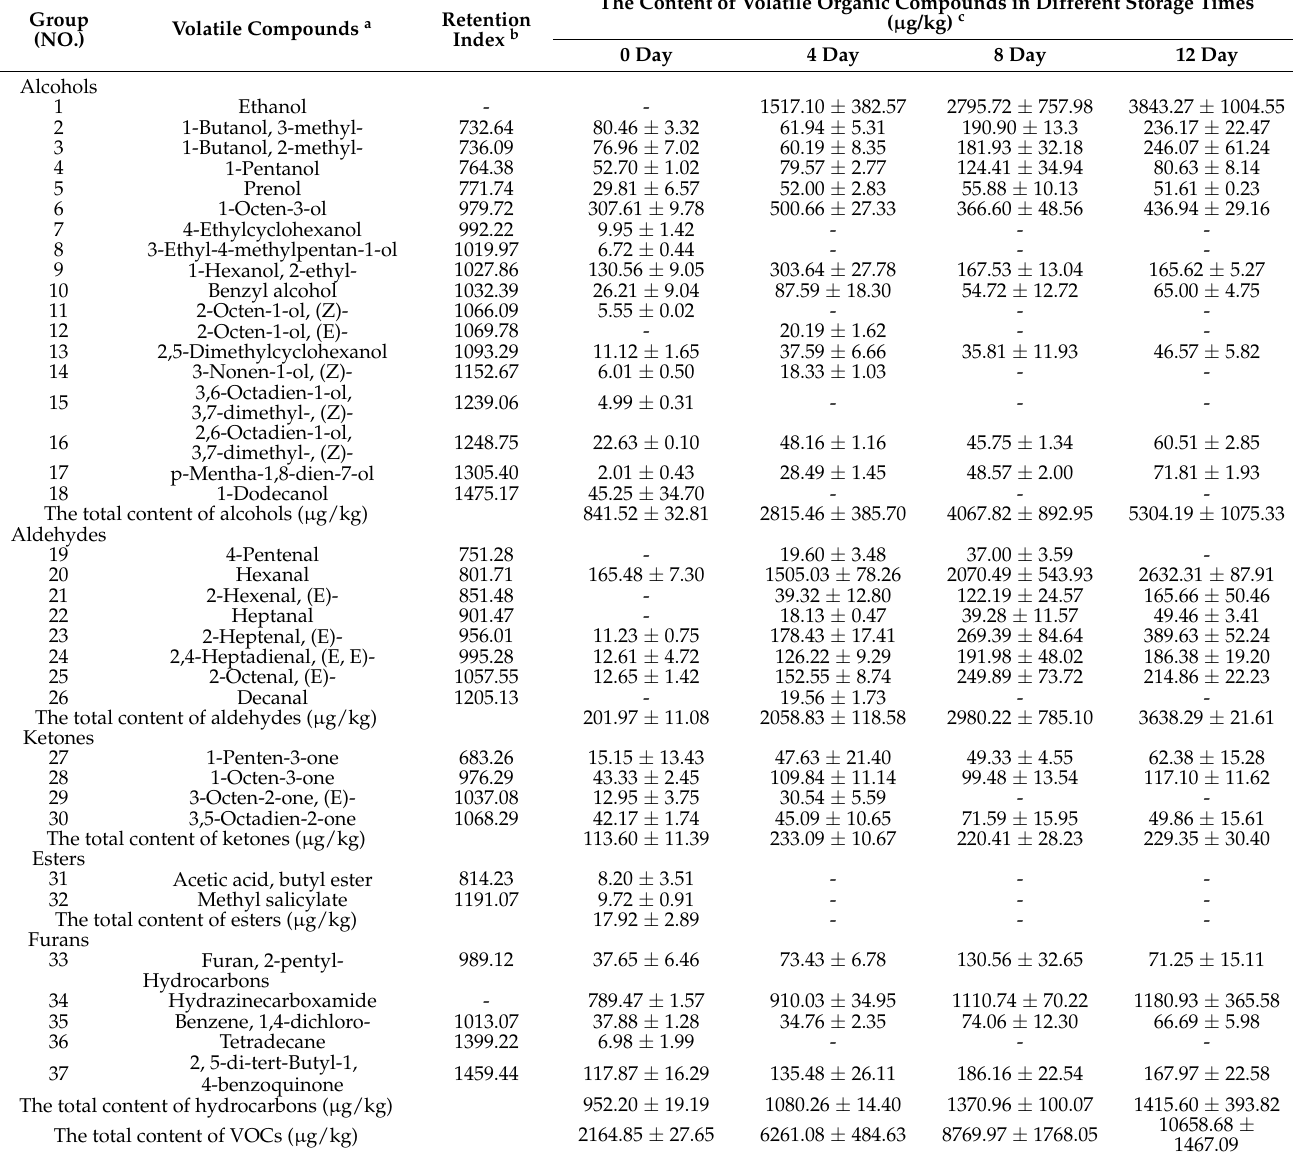
Table 2. The composition and content of VOCs of vacuum-packaged peeled potatoes during